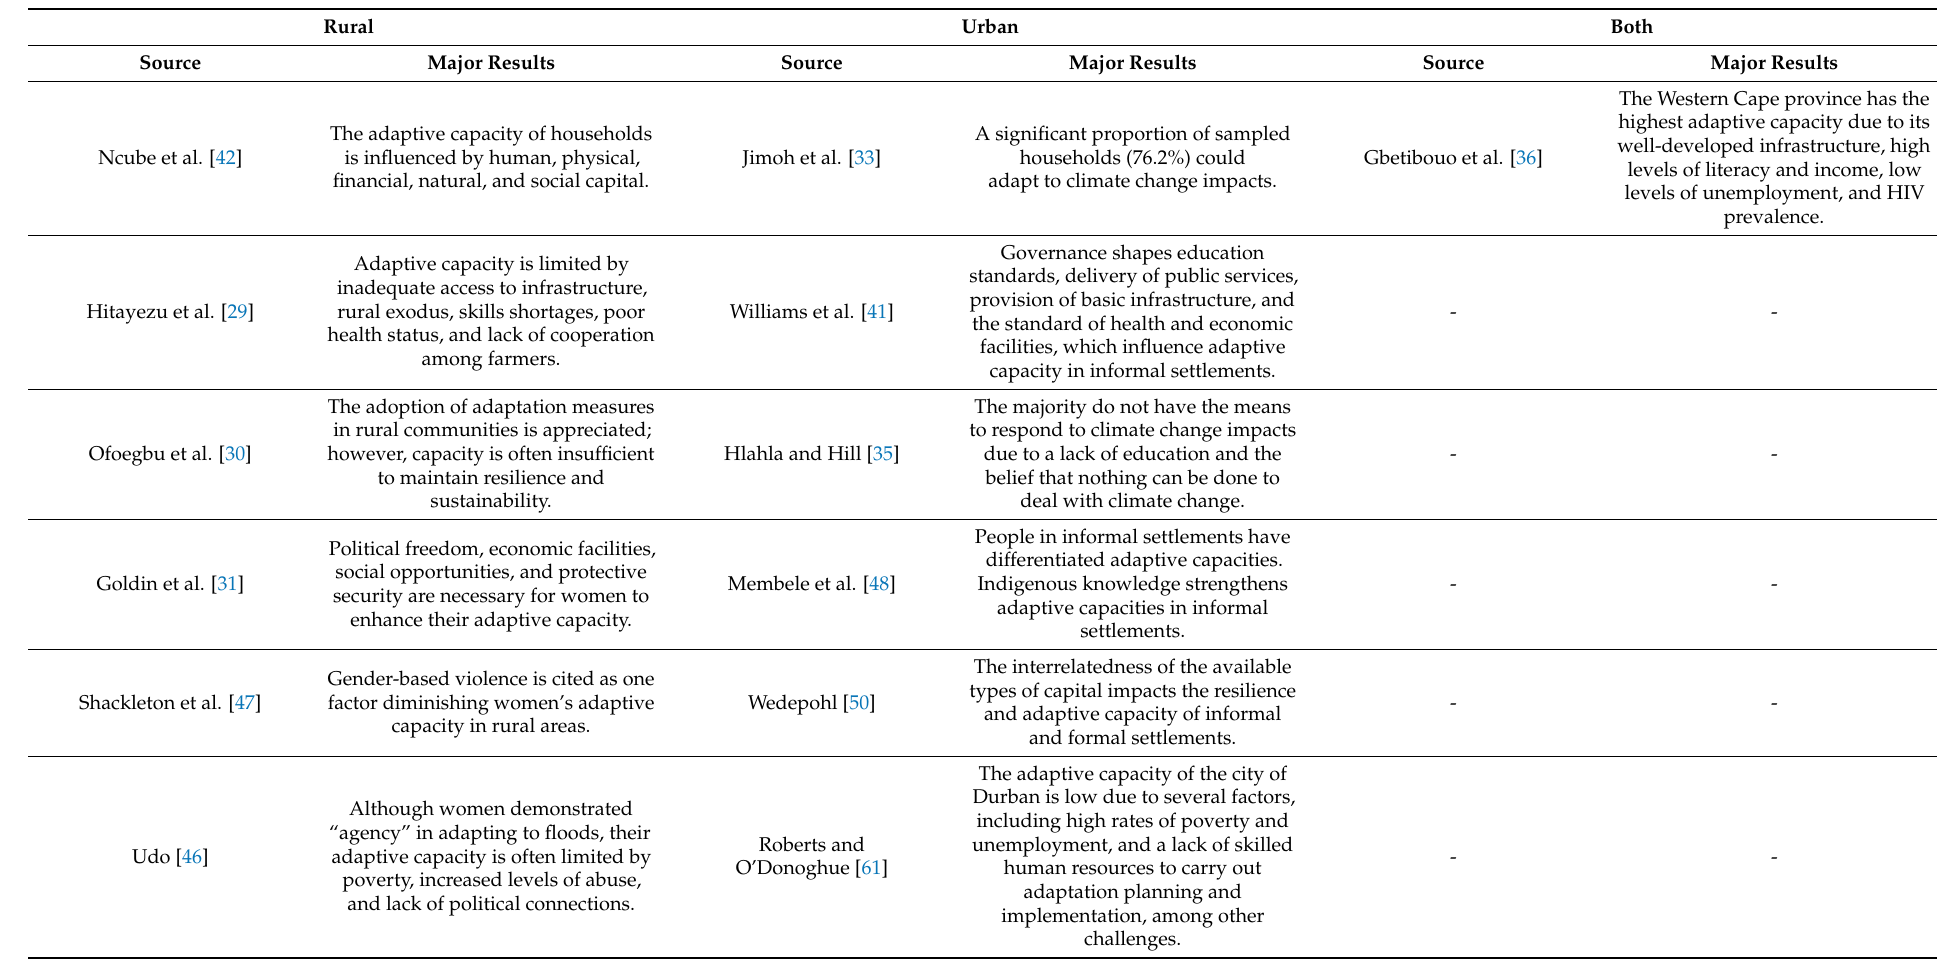
Table 4. Major results on the adaptive capacity of rural and urban areas in South